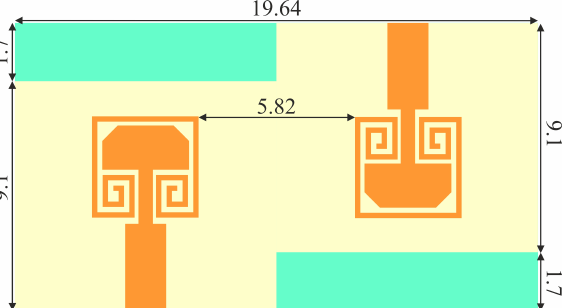
Figure 10. The layout of the inverted antenna element MIMO-2